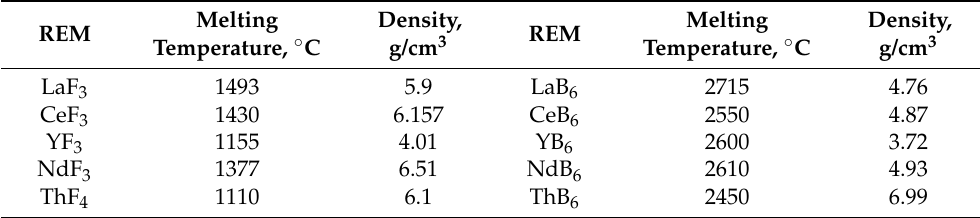
Table 1. Physical properties of fluorides and borides of rare earth metals (REMs) [15]. REM